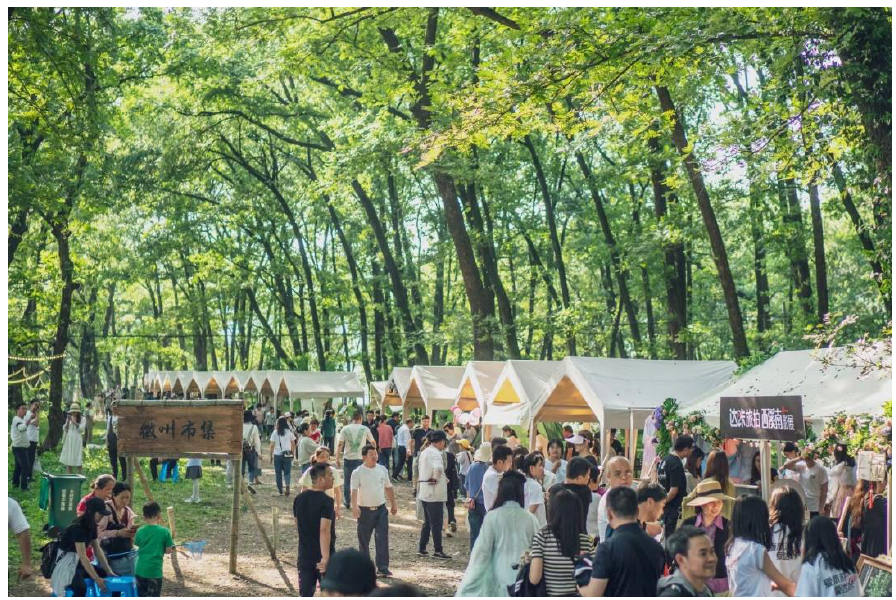
Figure 2. Traditional Huizhou style folk market in the maple forest. Source: the authors.